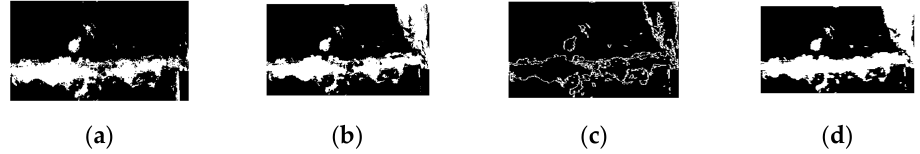
Figure 11. ( a ) Binary image before preprocessing; ( b ) binary image after preprocessing; ( c ) dilated edges with a line-shaped structural element; ( d ) connected area.